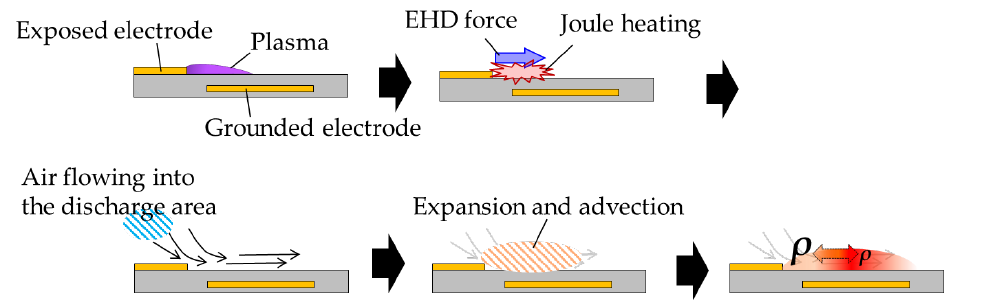
Figure 12. Forming mechanism of the flow and density field of the plate-PA.